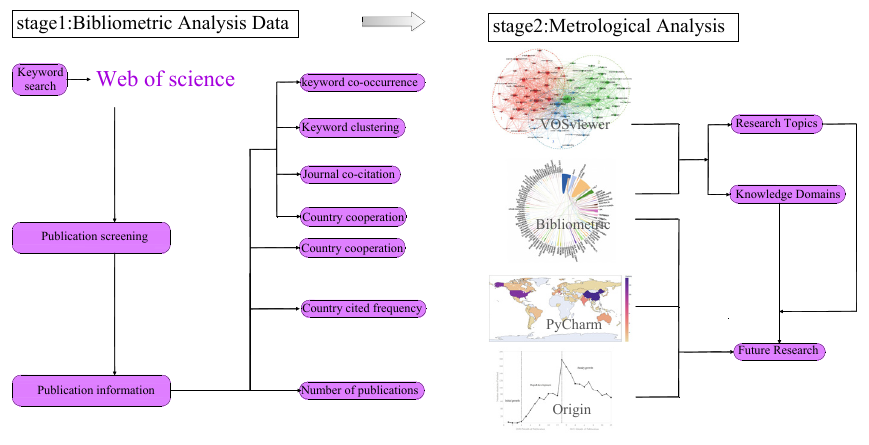
Figure 1. Workflow of the systematic.